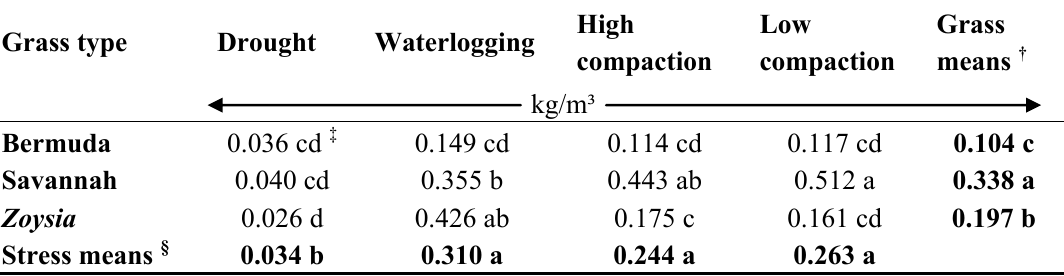
Table 3. Turfgrass RW affected by applied